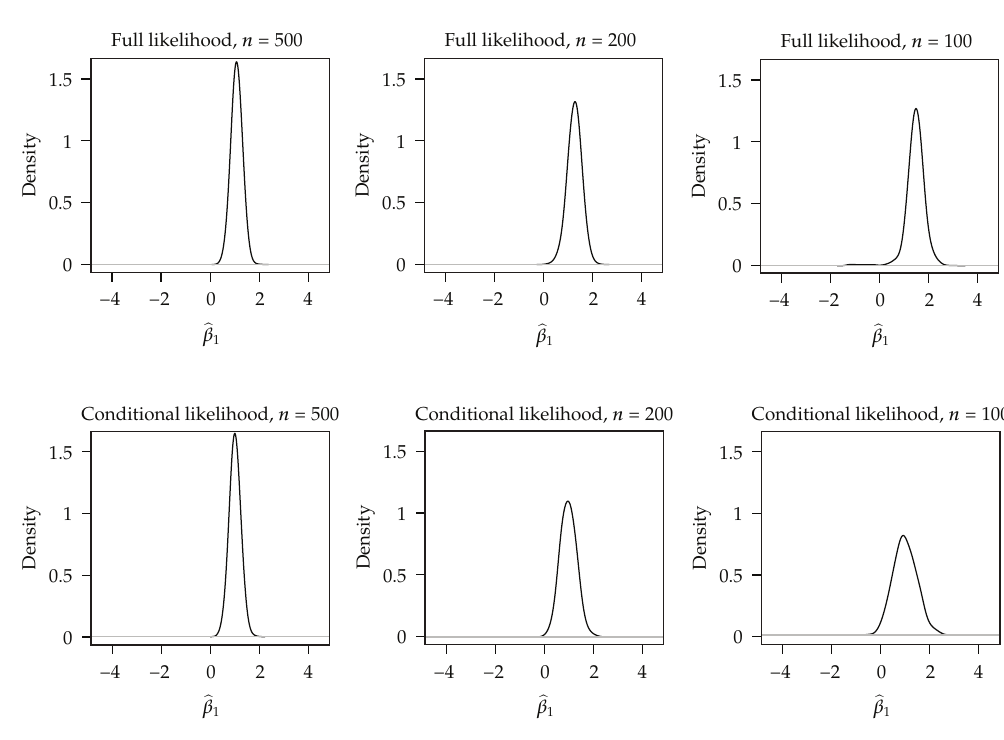
Figure 10: Sampling distributions for maximum likelihood estimates of regression coe ffi cient β 1 from 1000 replications; NPQM model fitted to gamma data (cid:5) Y i ∼ Z i (cid:9) Gamma (cid:5) 4 , 1 (cid:6)(cid:6)